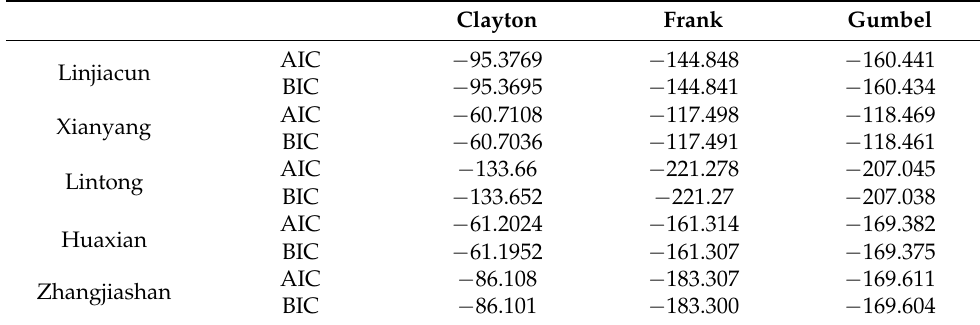
Table 5. The fitting excellence test of the Copula